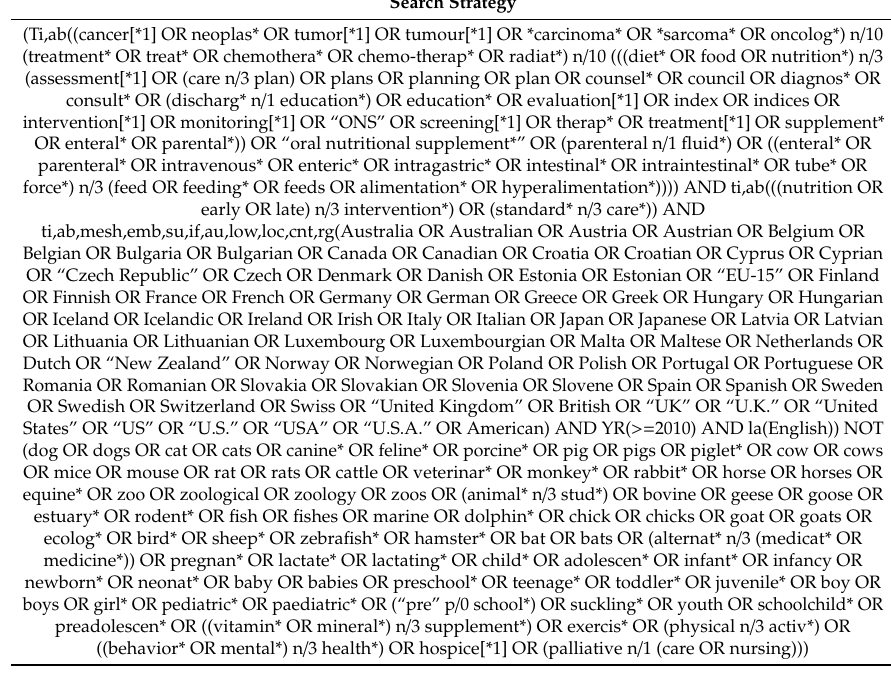
Table A1. Full electronic search strategy. Search